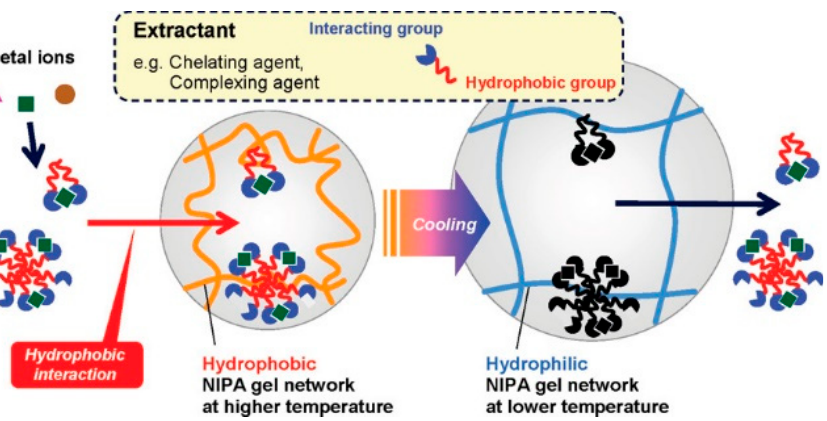
Figure 15. The proposed mechanism of heavy metal complexed with extractant onto N-isopropyl acrylamide hydrogel. (Reprinted with permission from Ref. [174]. Copyright 2022 American Chemical